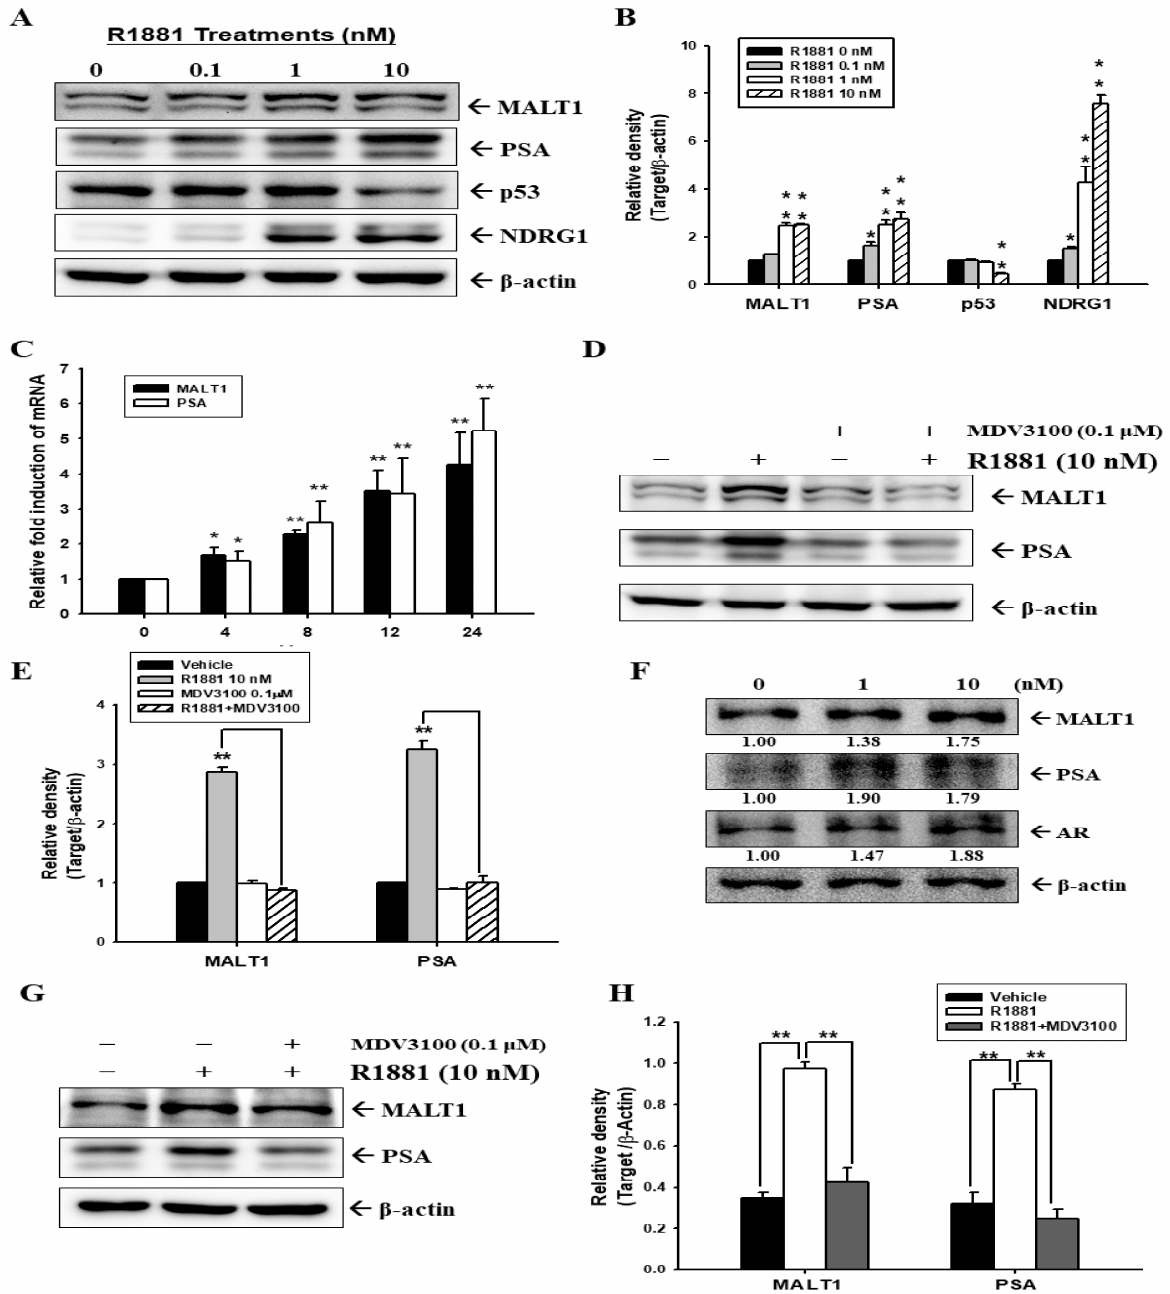
Figure 1. Effect of androgen on MALT1 expression in AR-positive prostate carcer cells. The LNCaP cells were treated with various concentrations of R1881 for 24 h. The cells were lysed and then MALT1, PSA, p53, NDRG1, and β -actin were determined by immunoblot assays ( A ) and the quan- titative data were expressed as the intensity of protein bands of the target proteins/ β -actin relative to the control vehicle-treated group ( B ). ( C ) The LNCaP cells were treated with 10 nM of R1881 as indicated. The mRNA levels of MALT1 and PSA relative to time 0 were determined by RT-qPCR assays. The LNCaP were cotreated with/without 10 nM R1881 and/or 0.1 µM MDV3100 as indicated for 24 h. The cells were lysed, then MALT1, PSA, and β -actin were determined by immunoblo tt ing ( D ) and quantitative analysis ( E ). ( F ) The 22Rv1 cells were treated with various concentrations of R1881 for 24 h. The cells were lysed and then MALT1, PSA, AR, and β -actin were determined by immunoblo tt ing. The numbers indicate the ratio of target proteins/ β -actin in relation to vehicle treat- ment. The 22Rv1 cells were cotreated with/without 10 nM R1881 and/or 0.1 µM MDV3100 as indi- cated for 24 h. The cells were lysed, then MALT1, PSA, and β -actin were determined by immunob- lo tt ing ( G ) and a quantitative analysis was presented as a relative density of MALT or PSA/ β -actin ( H ). * p < 0.05, ** p < 0.01. 2.2. Androgen Upregulates MALT1 to Promote PSA Expression in LNCaP Cells